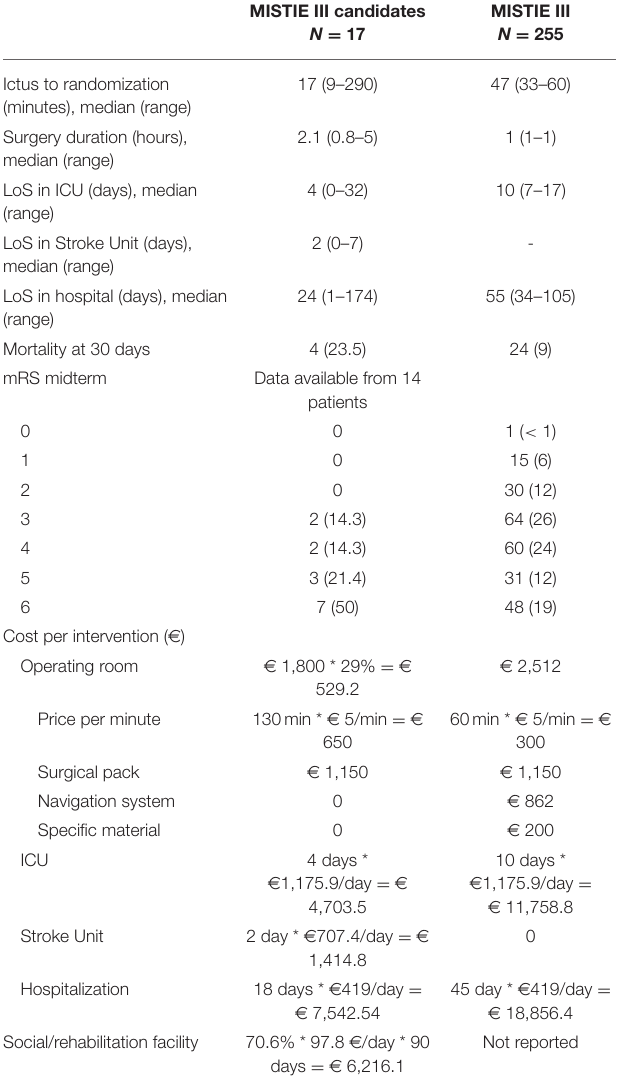
TABLE 4 | Cost-utility analysis of minimally invasive surgical techniques in TABLE 3 | Comparison of hospital resources needed for the two treatment hemorrhagic stroke; the reference is conventional alternatives and estimation of total costs. MISTIE III candidates N = 17